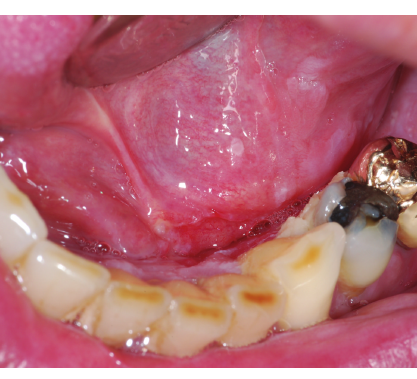
Figure 11: Case 4—a superficial ulcerous lesion atop of a mass at the left sublingual space with extension to the lingual aspect of the alveolar crest comprising the teeth 31 to 34 and surrounding leukoplakia.